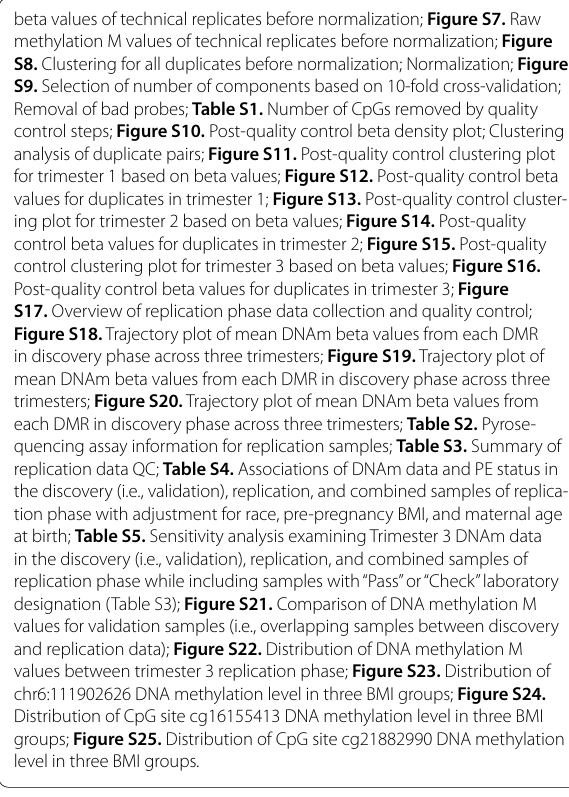
Figure S4. Mean detection p-values for each sample; Figure S5. Cluster- ing of samples based on median intensities; Figure S6. Raw methylation